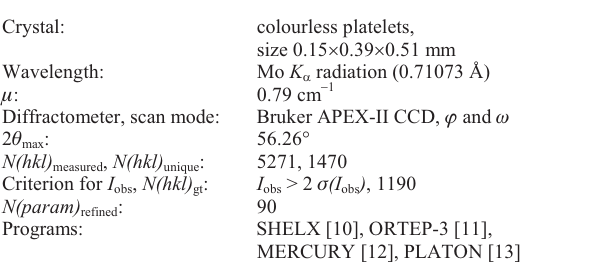
Table 1. Data collection and